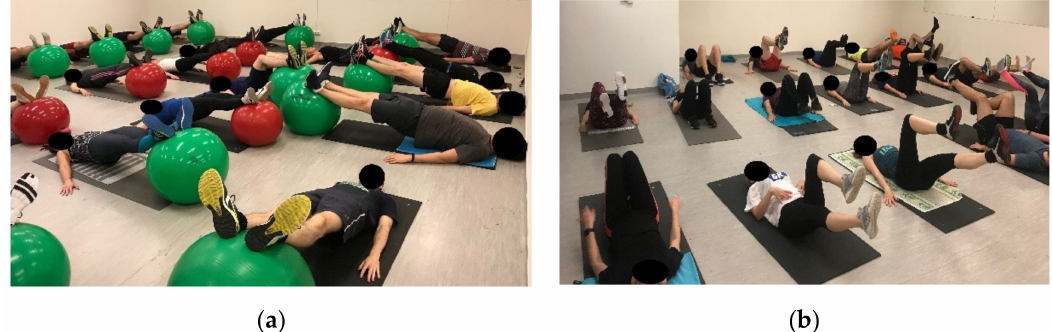
Figure 7. Segmental stabilization in unstable bilateral supine plank ( a ) and in stable unilateral leg lowering ( b ).